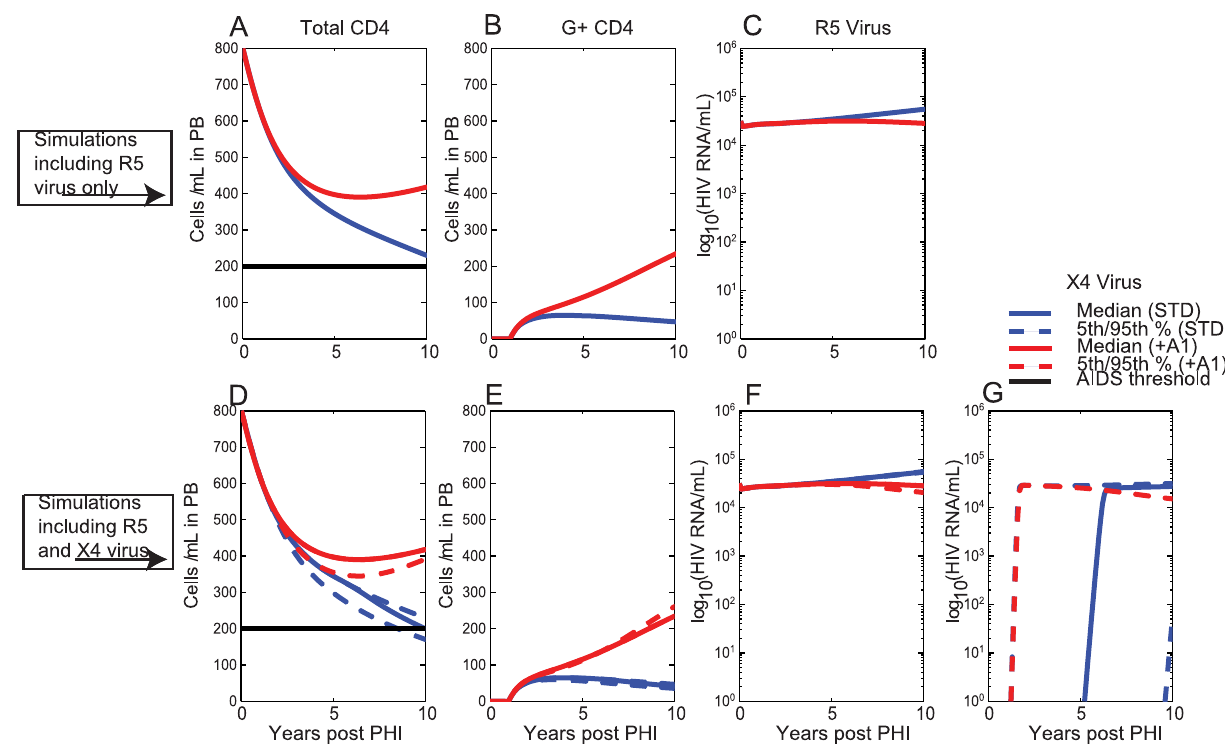
Figure 4. One-off delivery of gene therapy to CD34 + HSC assuming that 20% of CD34 + HSC in the bone marrow receive the gene construct at year 1. The legend for this figure is the same as for Figure 3.